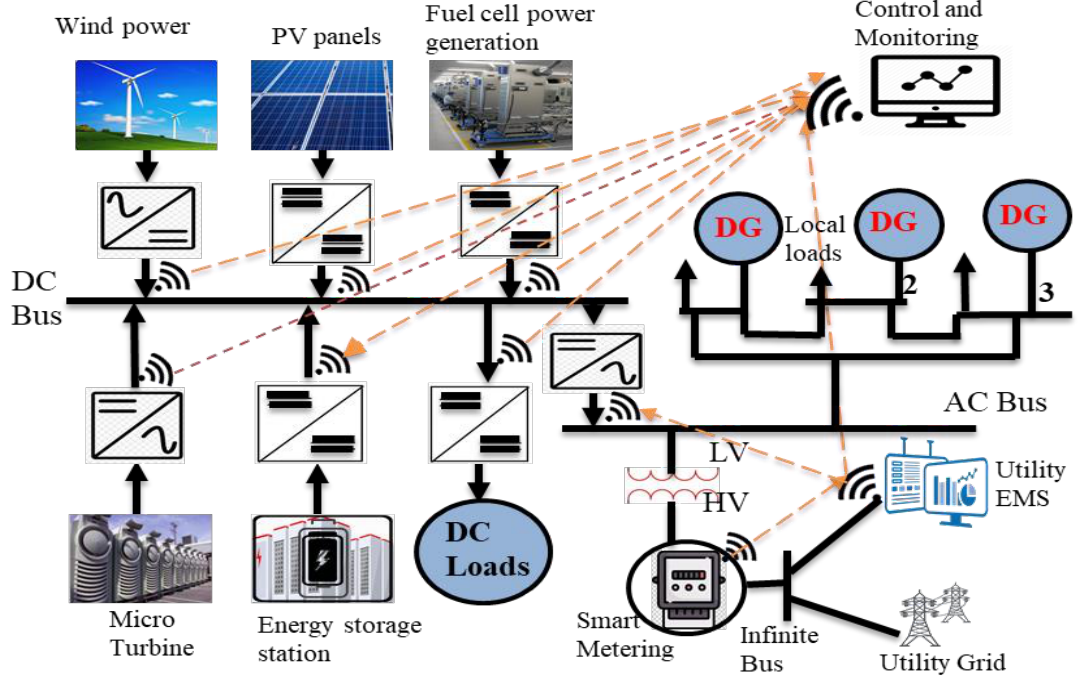
Figure 6. The Topology of Hybrid Microgrid System.